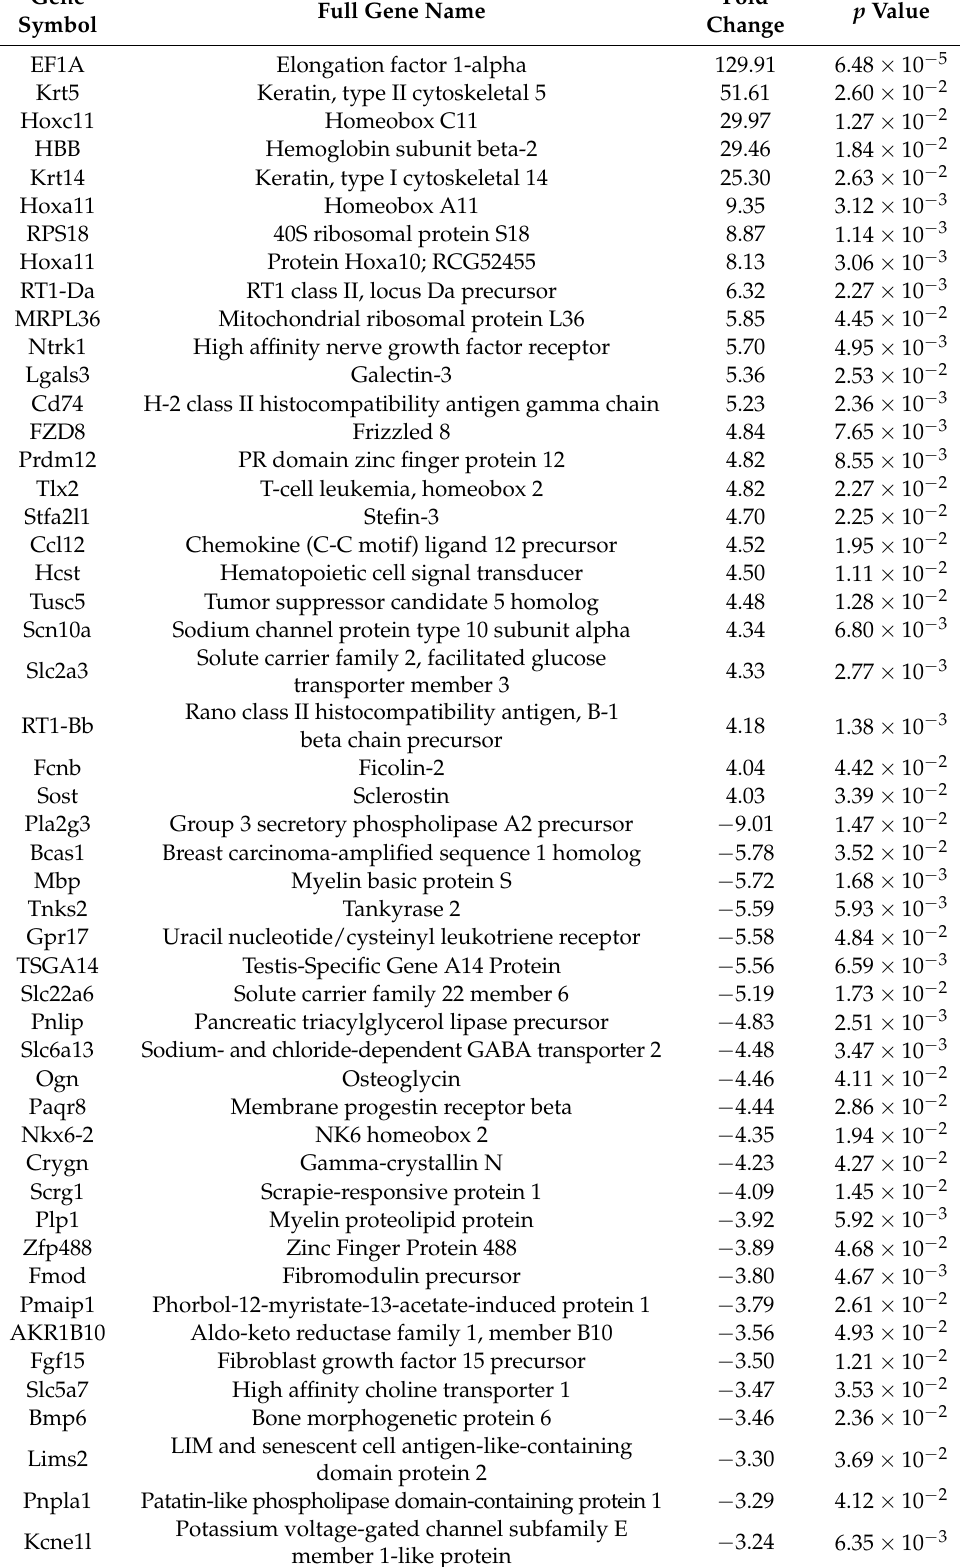
Table 5. Top 25 upregulated and downregulated genes between MMC and vehicle groups at E20.